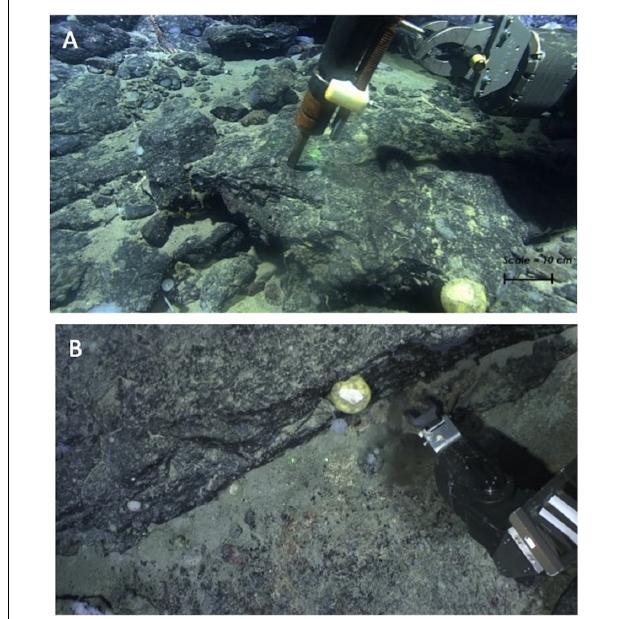
FIGURE 2 | Bedrock sampling from the ROPOS ROV. (A) Stanley CH15 hydraulic chipping hammer installed on ROPOS, sampling basalt bedrock on Orphan Seamount (ROPOS dive R1340, Pe-Piper et al., 2013). (B) Collecting a rock sample with the ROV manipulator arm, ROPOS dive R1341, SE Orphan Knoll. Note that because the rock samples were picked, rather than broken directly from exposed bedrock, there was greater risk of either collecting ice-rafted debris mistaken for bedrock, or of collecting Fe–Mn oxide crusts from the surface of bedrock